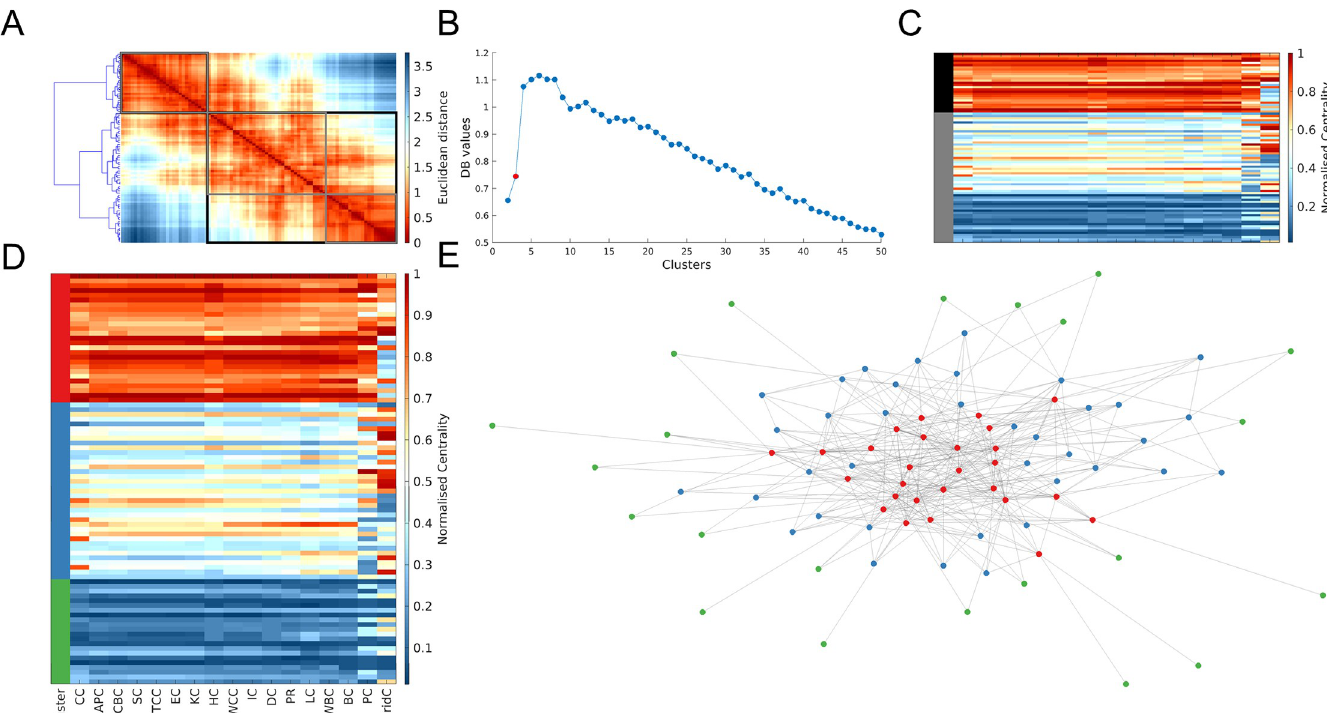
Fig 8. Multivariate centrality profiling of trophic-level species interactions in a New Zealand stream. Panel A shows the dendrogram projected alongside the distance matrix of node pairs (ranks scores were normalised to be in the range 0–1 with 1 indicating the highest rank). The black and grey boxes and indicate the clusters when a two-cluster and three-cluster solution is used, respectively. Panel B displays the results for the Davies-Bouldin (DB) criterion. A lower DB value represents a better clustering solution. The solution shown in panels D and E is labelled in red. Only the first 50 clustering solutions are shown for ease of visibility. Panel C shows the matrix of nodal centrality scores (each row is a node and each column is a measure) and how these are clustered in a two-cluster solution (the black and grey represent the two different clusters). Panel D shows the matrix of nodal centrality scores as well as the clusters each node was assigned to. Panel E shows a topological representation of the network, produced using the force-directed layout algorithm, where each node is coloured according to the cluster it was allocated to in panel D .